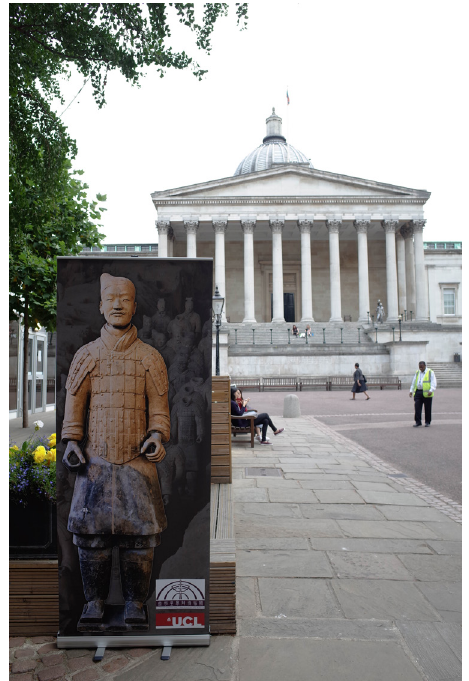
Figure 3: Poster advertising the symposium entitled ‘Emperor Qin Shihuang’s Mau- soleum in Global Perspective’ (Photo Lisa